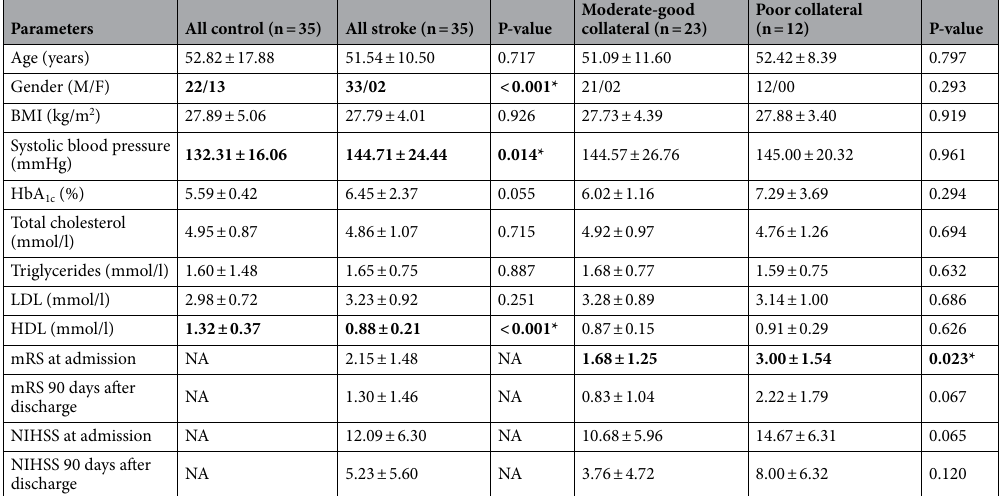
Table 1. Demographic, metabolic, and clinical characteristics of healthy controls and participants with acute ischemic stroke with moderate-good and poor pial collaterals expressed as mean ± SD. *Statistically significant differences between